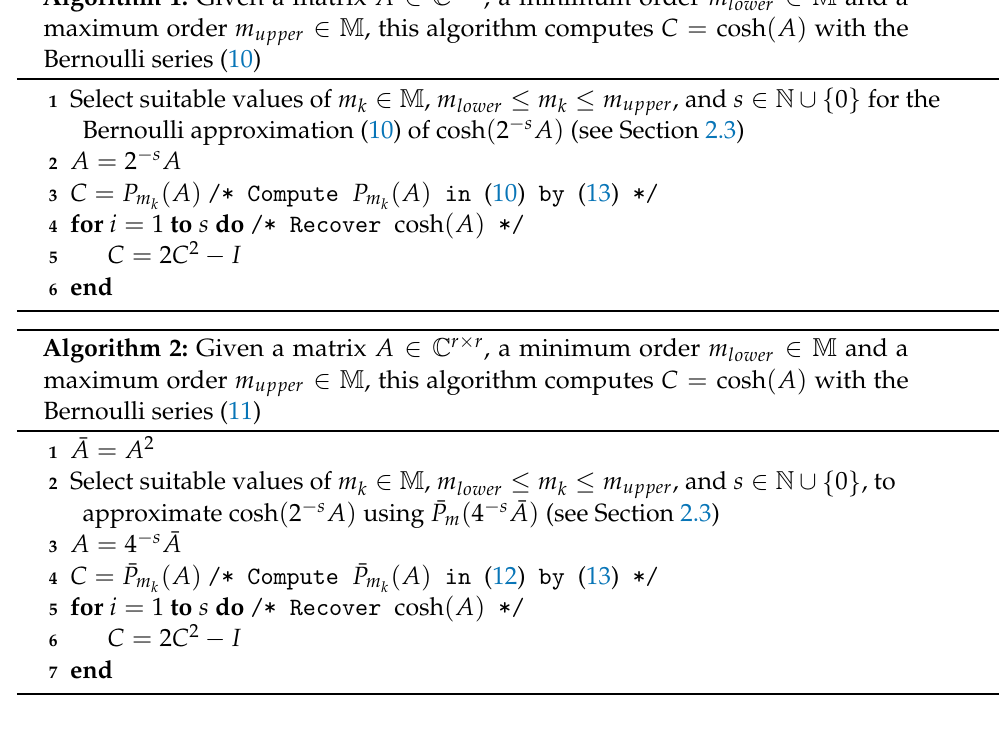
Algorithm 1: Given a matrix A ∈ C r × r , a minimum order m lower ∈ M and a